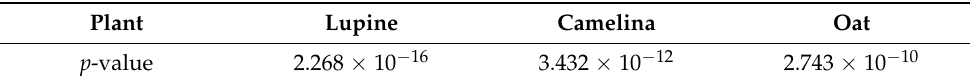
Table 4. p -values obtained for combinations of factors levels from the Kruskal–Wallis test for plants. Small p -values indicate that treatment had a significant effect on content of considered elements separately in each plant. Plant